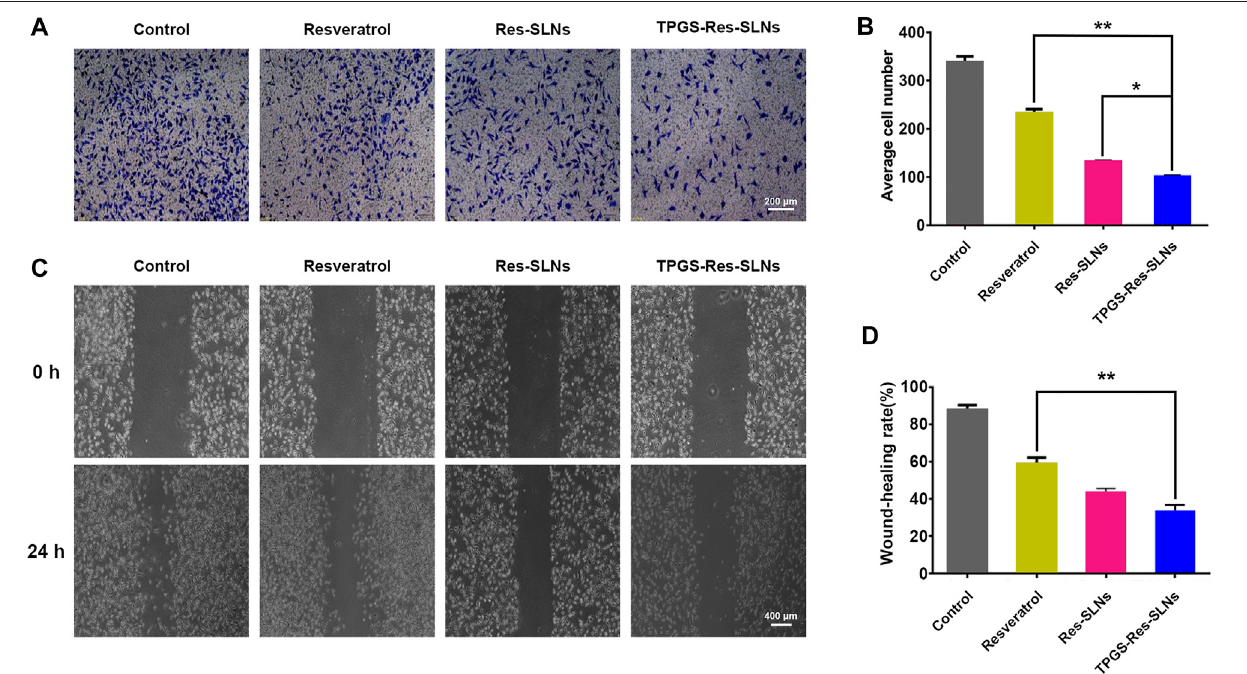
FIGURE5| TPGS-Res-SLNsinhibitedinvasionand migration abilityofSKBR3/PRcells invitro (A) Transwellmigrationassaywasusedtodetectthenumberof trans-membrane cells. Representative microphotographs of the Boyden chamber assay of SKBR3/PR cells. (B) The quantitative data for the Boyden chamber assay. The bar graph represents the number of invasive cells present per unit area in different treated groups. (C) Wound-healing assays were performed to assess cell migration. Cells were treated with Resveratrol, Res-SLNs and TPGS-Res-SLNs for 0 and 24 h or untreated. Representative images of treated and untreated cells areshown. (D) Distance migrated by cells atthe 24h are shown. Thevaluesrepresent themean ± SD ofthree independentexperiments. (** p < 0.01, * p <